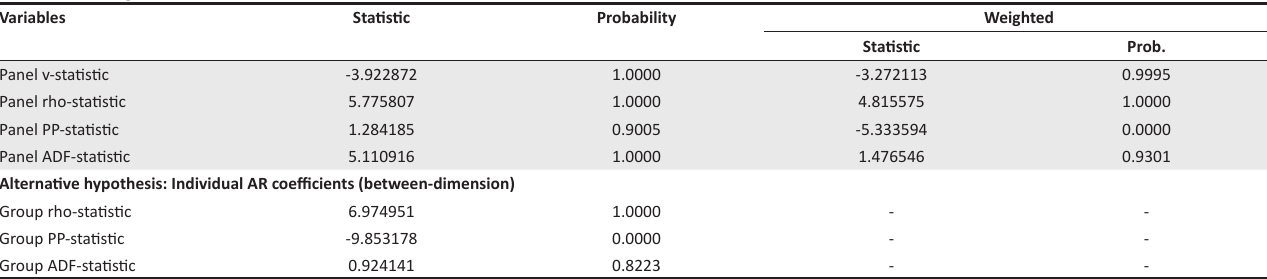
TABLE 4: Co-integration test.